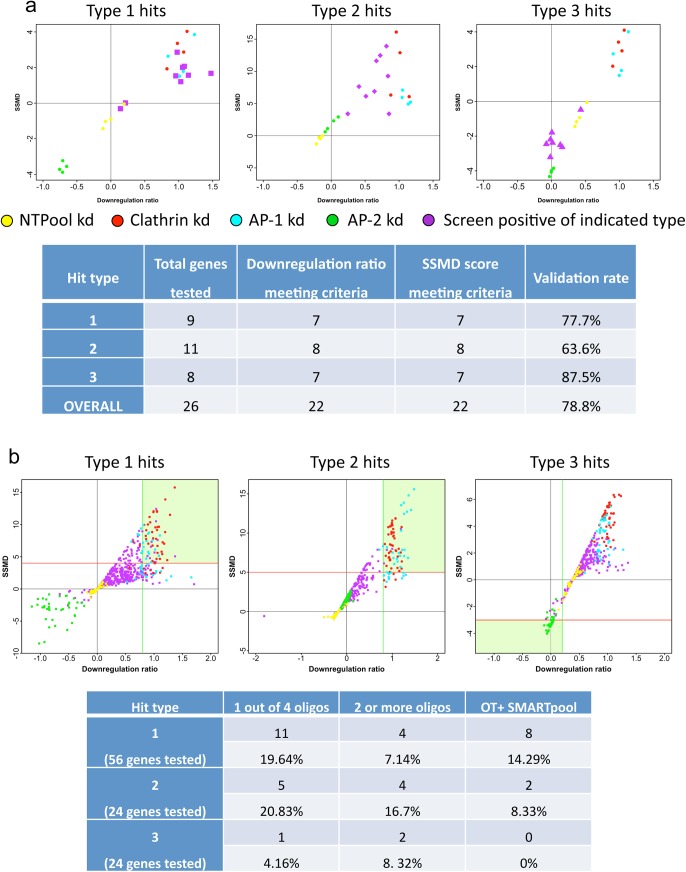
Results of validation experiments.a, Pilot experiment carried out using the same siRNA reagents as the primary screen. The downregulation ratio (x axis) is plotted against the SSMD score (y axis) for each type of hit. Most of the hits were validated. b, Validation experiment using different siRNA reagents. The downregulation ratio (x axis) is plotted against the SSMD score (y axis) for each type of hit. The green shading marks the area from which hits were selected. Very few of the hits came through when we used different reagents.